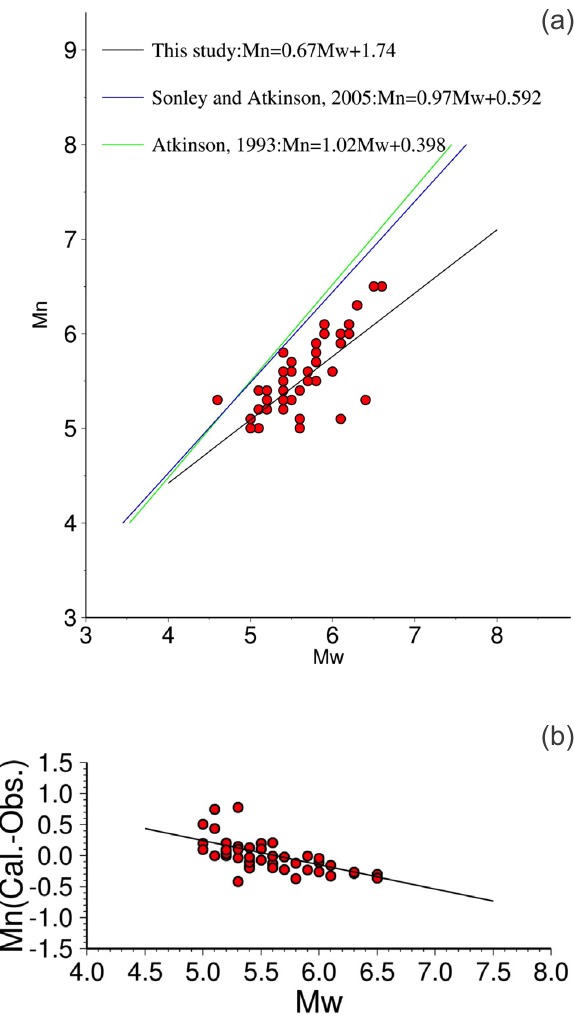
( M ) versus M . Lines are for com- Figure 5. (a) Empirical relationship between M L 10 0 Atkinson [1993] and Sonley and Atkinson [2005] equations corre- spond to the green and blue lines, respectively. Equation of the black line gives the regression result for this study. The two men- tioned relationships (the American and Canadian) are very similar to each other. There is a vastly different magnitude range in the Iranian data. (b) Difference between the calculated and observed M versus M for the Iranian W N